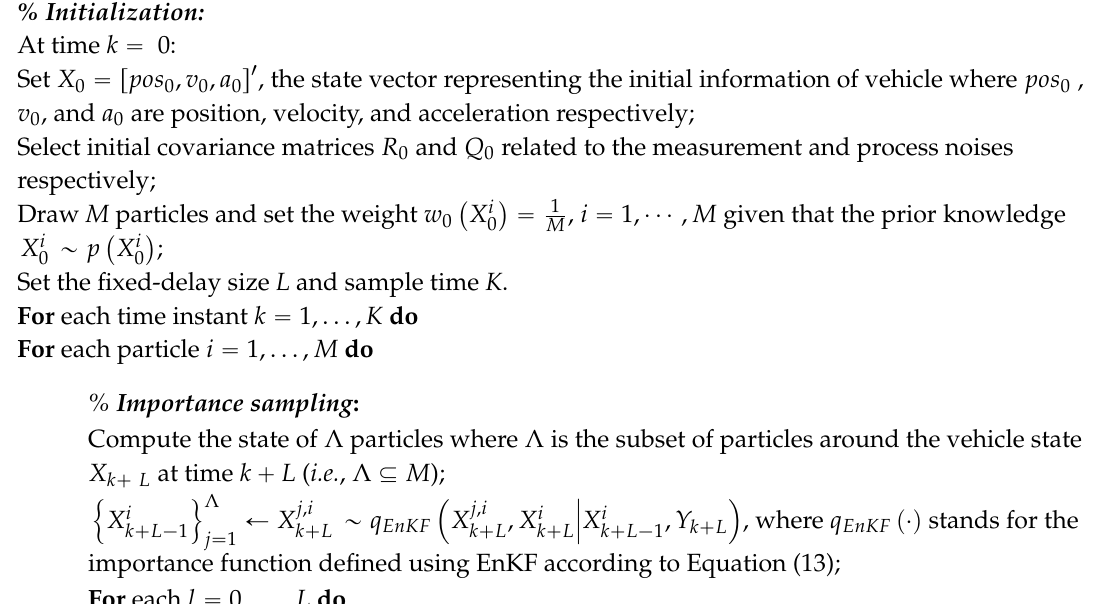
Algorithm 1 Non-Gaussian Delayed Particle Smoother (nGDPS) for Vehicle